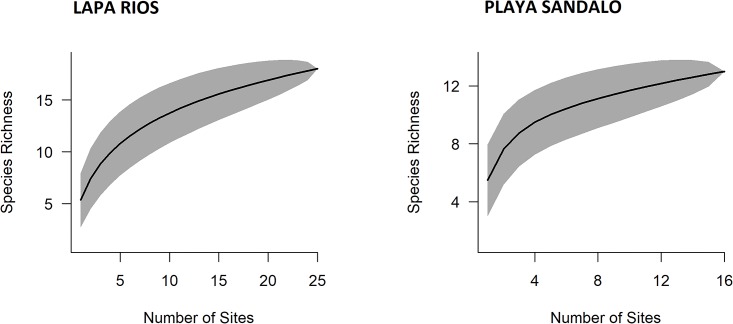
Rarefaction species-accumulation curves per camera trap site for Lapa Rios Ecolodge Nature Reserve and Playa Sandalo.Included average rarefaction curve and 95% confidence intervals based on species richness and frequency counts per site. The total data collected included: Lapa Rios (12 species and 90 individuals) and Playa Sandalo (17 species and 202 individuals).